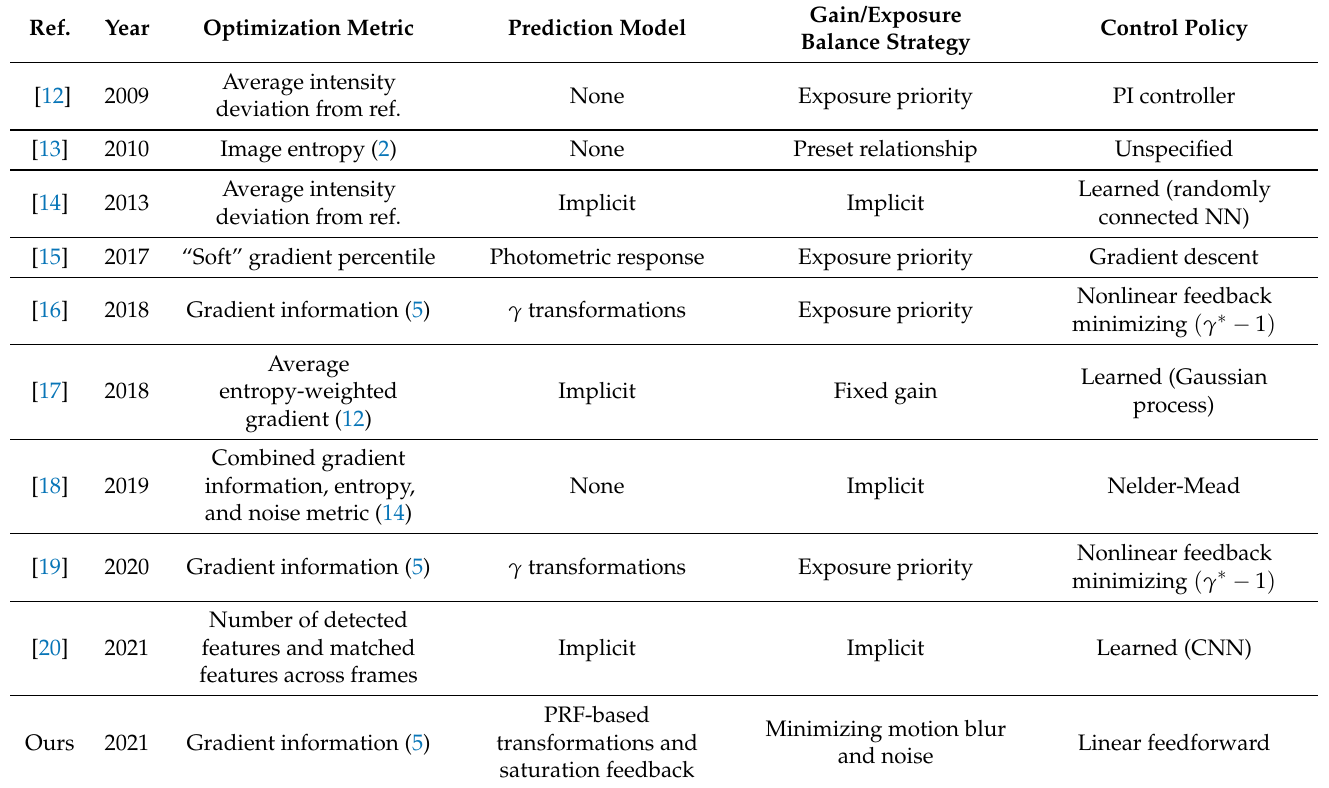
Table 1. AE algorithms for VO/SLAM